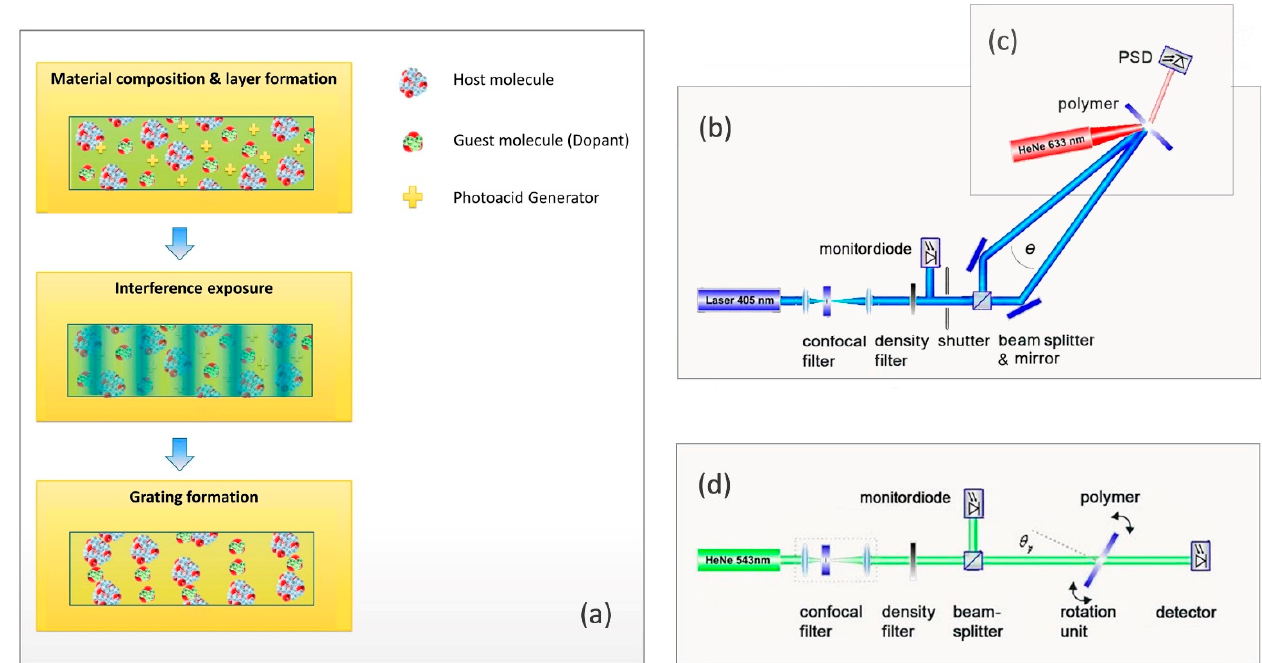
Figure 1. Overview on Materials and Methods: ( a ) Schematic illustration of composition, exposure, and grating formation for the host–guest material. ( b ) Holographic exposure setup with geometry for transmission gratings. ( c ) In situ setup for the investigation of hologram formation in real time. ( d ) Rotation-scan setup for angular resolved analysis of final gratings.